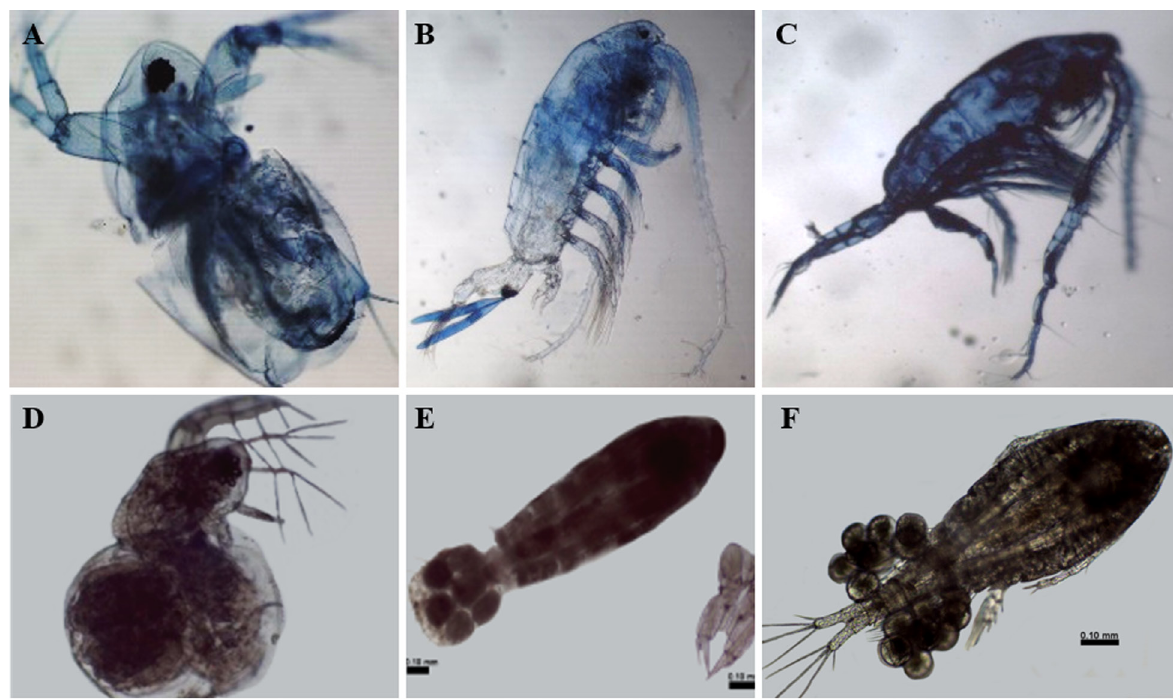
Figure 2. Dead (bright blue colour a–c) and alive (natural colour of the animal d–f) microcrustaceans in three reservoirs in the neotropical semiarid ecosystems (Pernambuco, Brazil). a and d - Moina micrura Kurz, 1874; b, c, and e - Notodiaptomus cearensis (Wright, 1936); F - Thermocyclops decipiens (Kiefer,